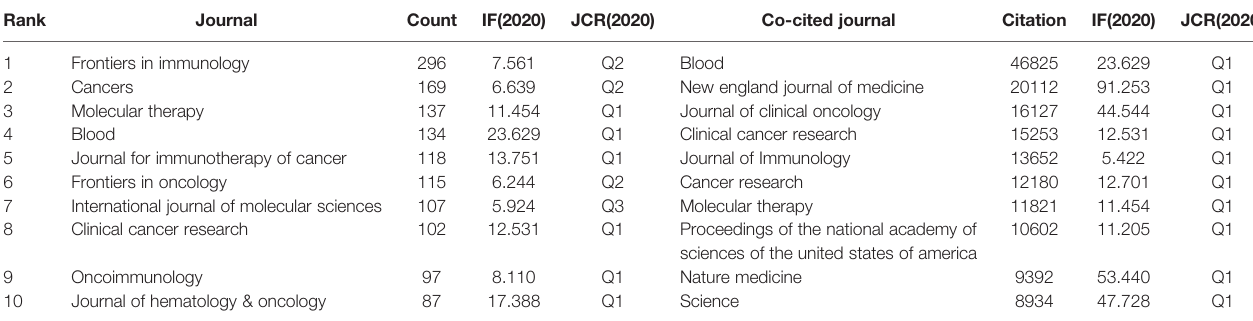
TABLE 2 | Top 10 journals and co-cited journals related to CAR-T